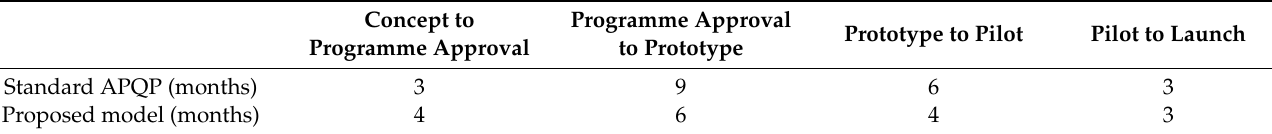
Table 2. Timing comparison between standard APQP timing duration and the proposed